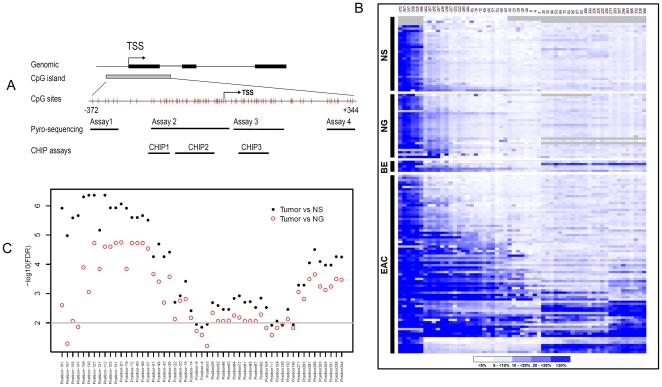
DNA methylation levels of the MT3 promoter in esophageal adenocarcinomas and normal tissue samples.
A) Schematic illustration of MT3 genomic structure and the Pyrosequencing and ChIP assays. The MT3 gene comprises of 3 exons (black boxes). There is a long CpG island extending from upstream of the transcription start site (TSS) to the first intron (grey box). Each grey vertical bar represents one individual CpG site from −372 to +344. Four Pyrosequencing assays (assay 1–4) and three ChIP assays (ChIP 1–3) are shown. B) Heat map of DNA methylation profile from −372 to +344 in normal esophageal squamous mucosa (NS), normal gastric glandular mucosa (NG), Barrett's esophagus (BE) and esophageal adenocarcinoma (EAC) samples. A key for the blue scale is given below the map. Grey areas indicate missing data. C) Significance analysis of DNA methylation levels in the MT3 promoter region from −161 to +344 of TSS between EAC and normal samples. Each dot or cycle represents one comparison between tumor and normal samples for one CpG site, as indicated. The graph is plotted for the mean value in all tumor samples, as compared to the mean value for all normal samples (NS or NG) in each CpG site. FDR (false discovery rate) was used to demonstrate the significance and is plotted as −log10(FDR) in y axis. Thus, if FDR<0.01 then −log10(FDR)>2.0. We used FDR≤0.01 as the cutoff for statistical significance.